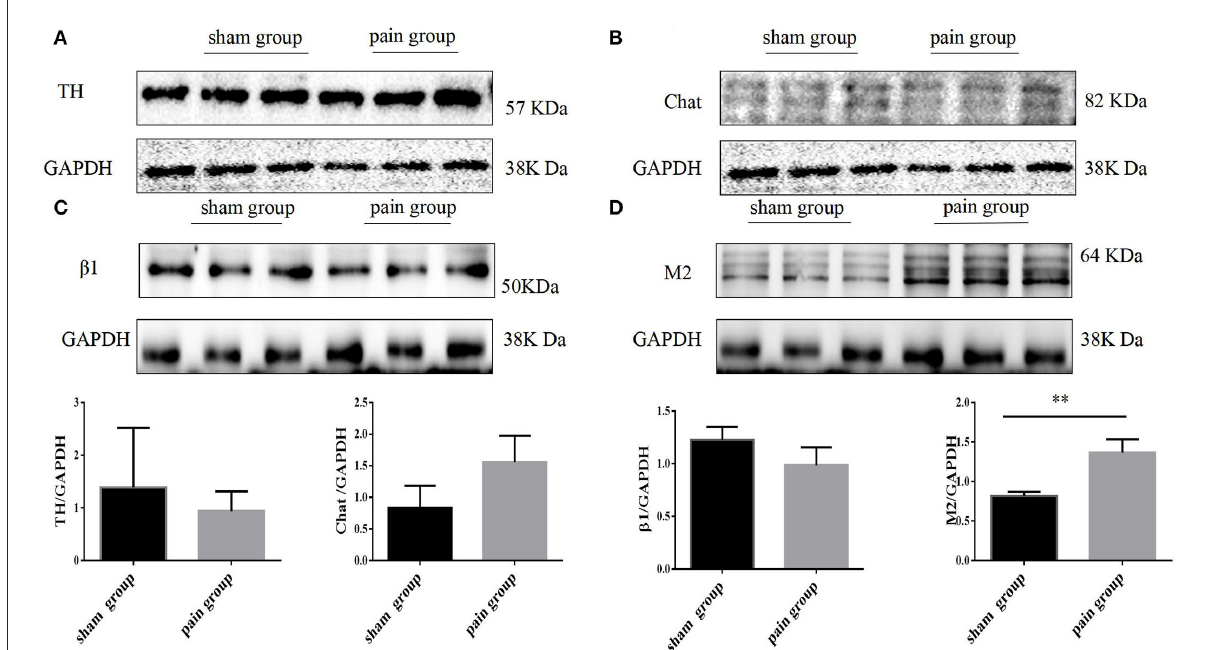
FIGURE5 Autonomic nervous system related protein expression by Western blot. (A) Tyrosine hydroxylase (TH), (B) choline acetyltransferase (Chat), (C) adrenergic β 1 receptor, and (D) muscarinic acetylcholine M2 receptor expression with Western blot in sham and pain groups. The results are expressed as mean ± standard deviation. The histograms represent values. ** represents p < 0.01 (two-tailed Student’s t